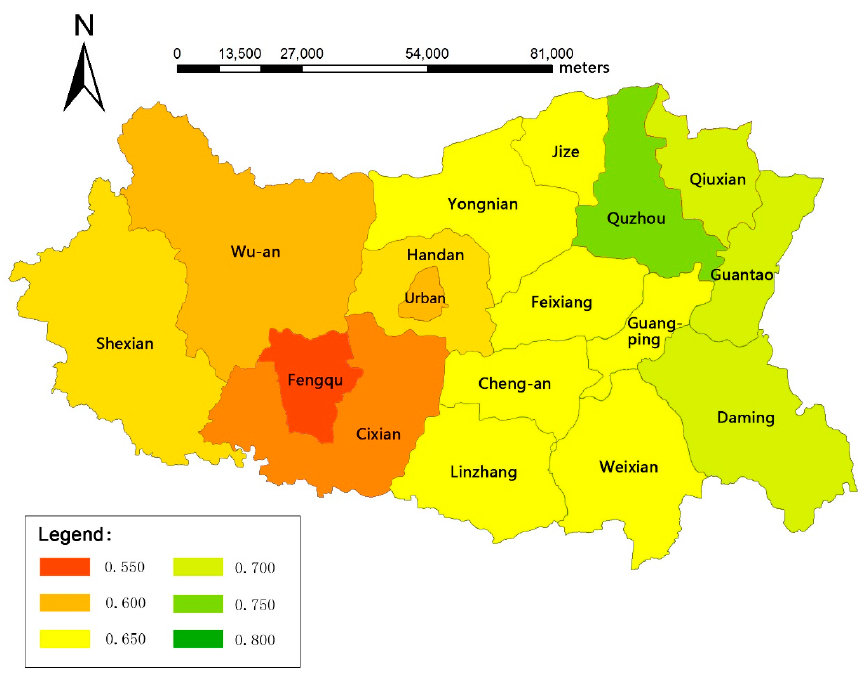
Figure 8. Spatial distribution of SWA in the hydrological wet year (2012).